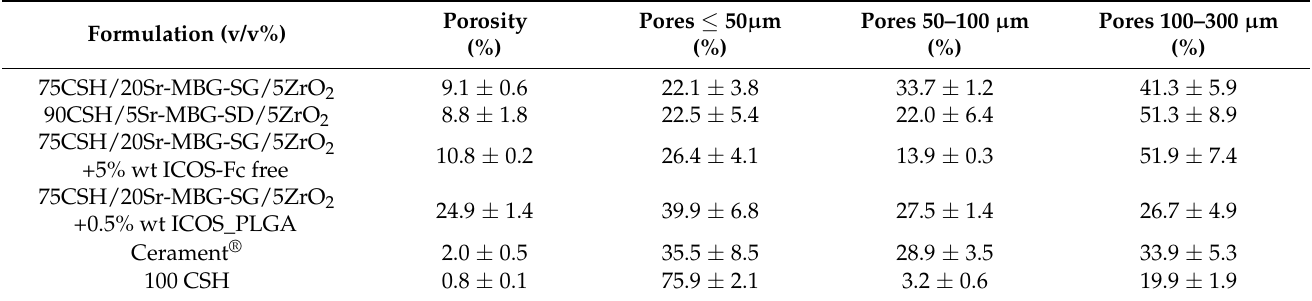
Table 4. Percentage of porosity and percentage of the pores of the investigated cements calculated by means of CTAn software with diameter lower than 50 µ m, between 50 and 100 µ m and between 100 and 300 µ